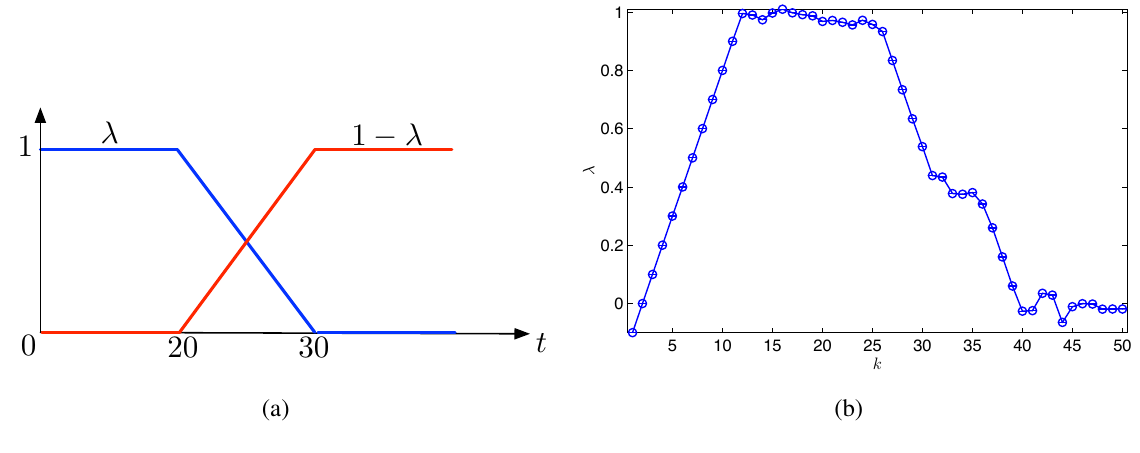
Table 2. Parameters used in